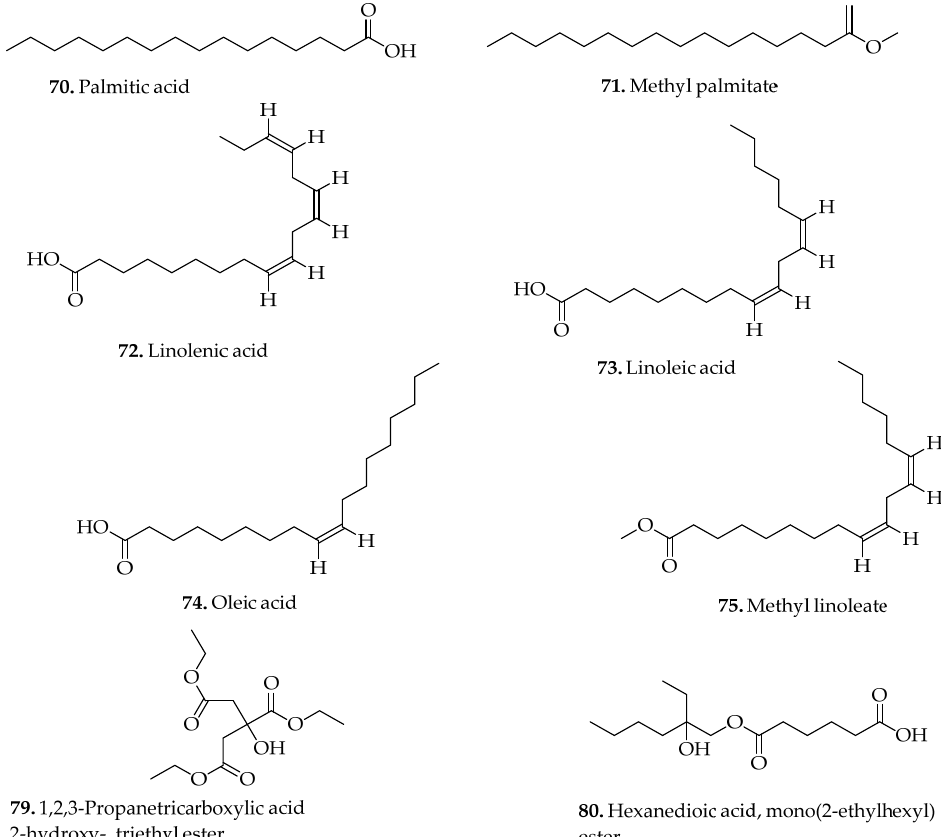
Figure 9. Representative chemical structures of fatty acids isolated from Blechnum species . Table 2. Screened secondary metabolites from the Blechnum species.